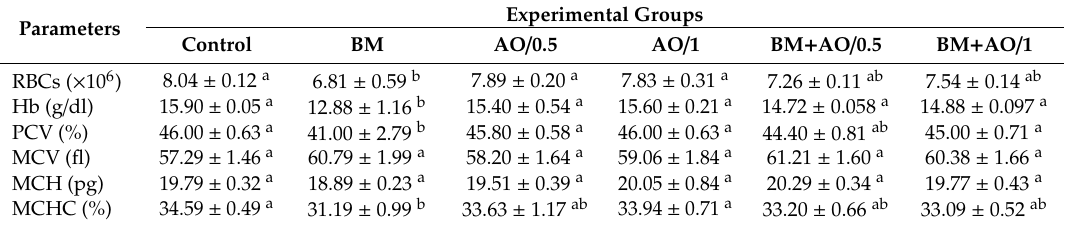
Table 2. E ff ect of betamethasone and / or argan oil on erythrogram parameters of di ff erent treated groups.